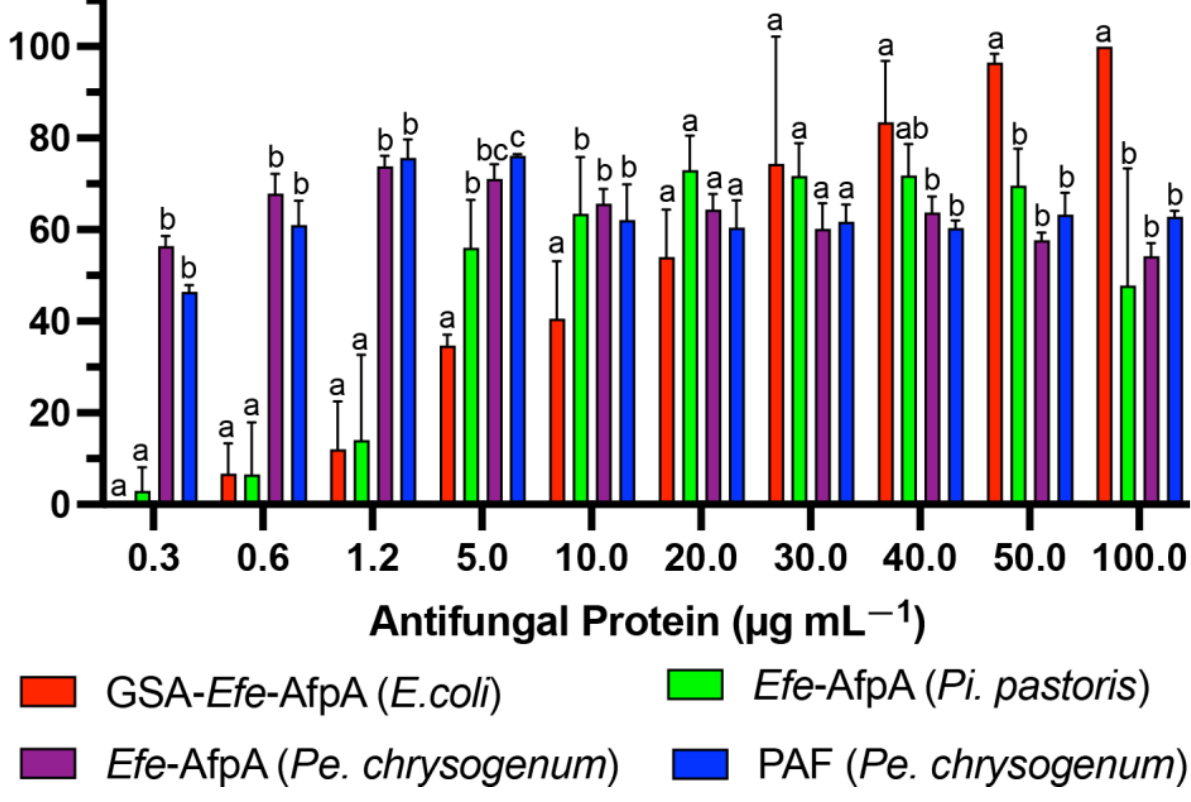
Figure 4. Comparison of activities of PAF purified from Pe. chrysogenum and Efe -AfpA purified from E. coli , Pi. pastoris , and Pe. chrysogenum . Increasing concentrations of the antifungal proteins were assayed for activity in the N. crassa growth assay with 1 × 10 6 conidia mL − 1 . The data presented are the means and standard deviations of three replicates. For each concentration, columns with different letters indicate a significant difference in activity ( p ≤ 0.05, two-way ANOVA). Table 2. Yield of purified Efe -AfpA from the different expression systems. Expression System